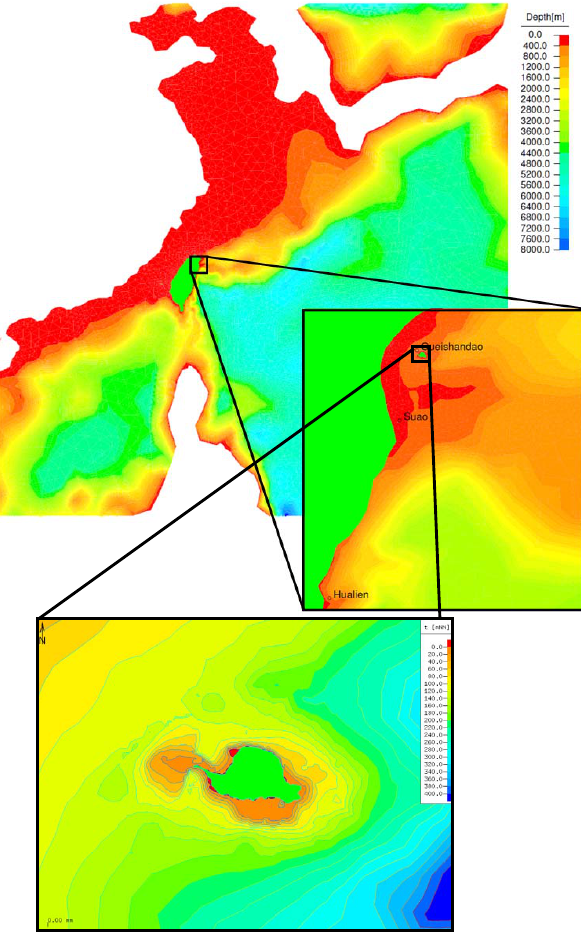
Fig. 6. Depth distribution in the modelling region around Guishandao